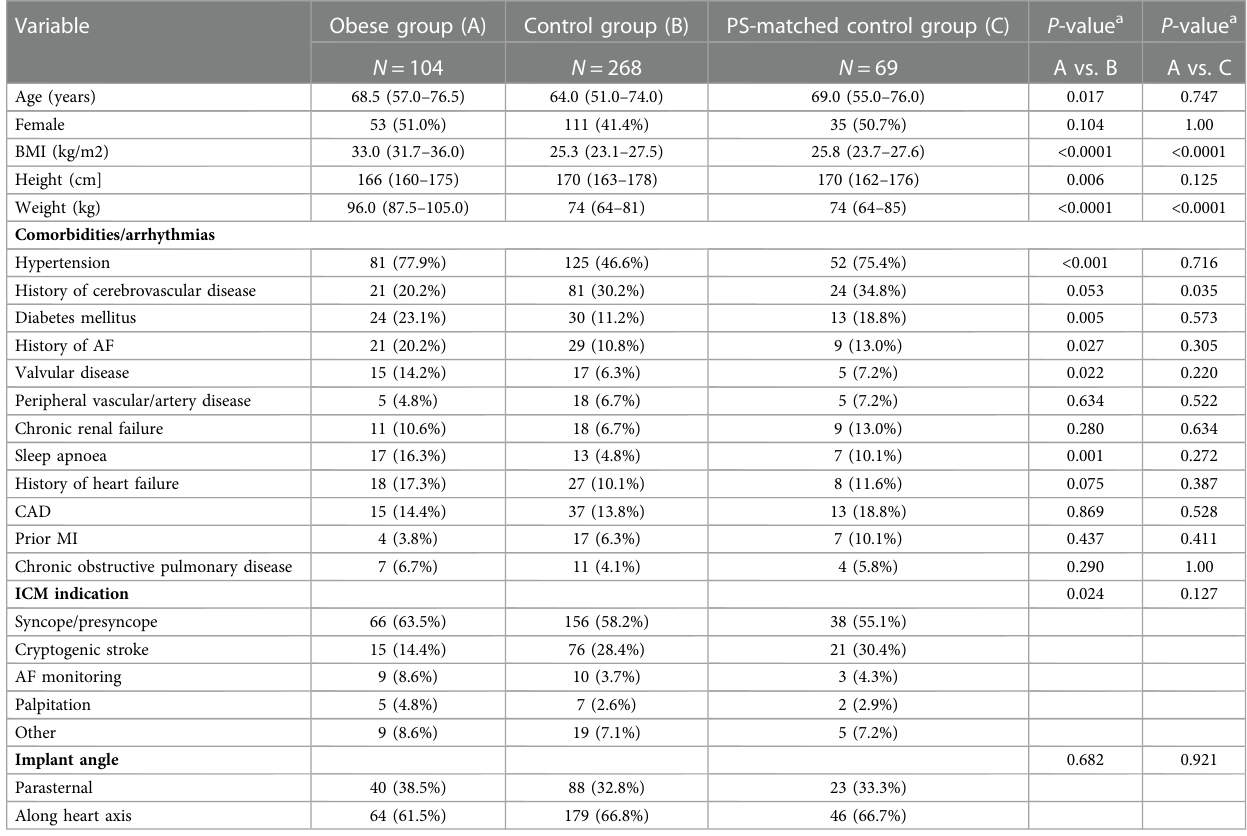
TABLE 1 Patient characteristics at the time of ICM